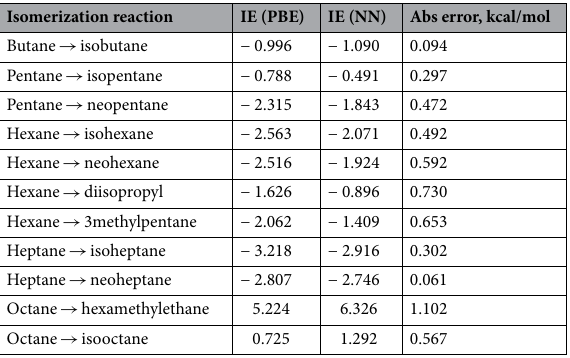
Table 3. Results of testing NN XC functional on Alkisomer11 dataset. IE denotes isomerization energy.